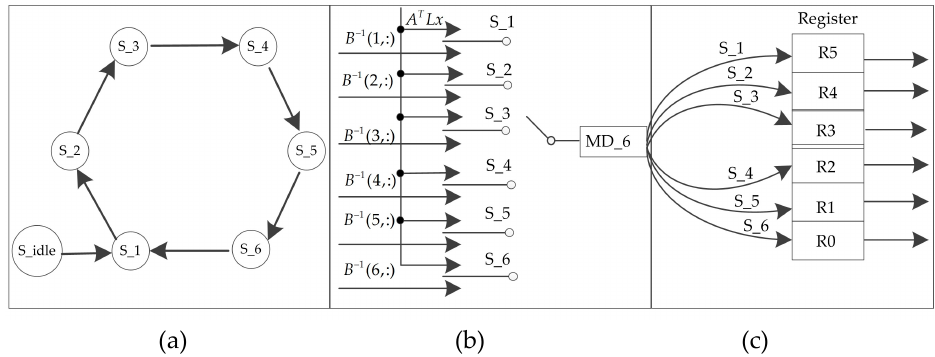
Figure 13. The processing of state transition graph (STG). ( a ) The state machine. ( b ) Serial framework. ( c ) Serial input and parallel output.